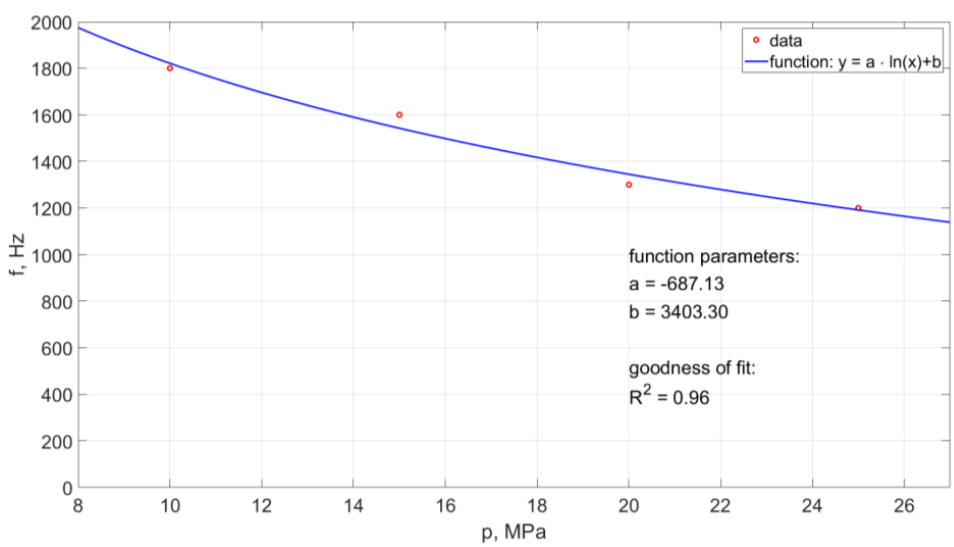
Figure 23. The waveform of the frequency of hydrodynamic pulses recorded with a force sensor for a self-excited pulse head designed for drilling holes working in an aquatic environment.